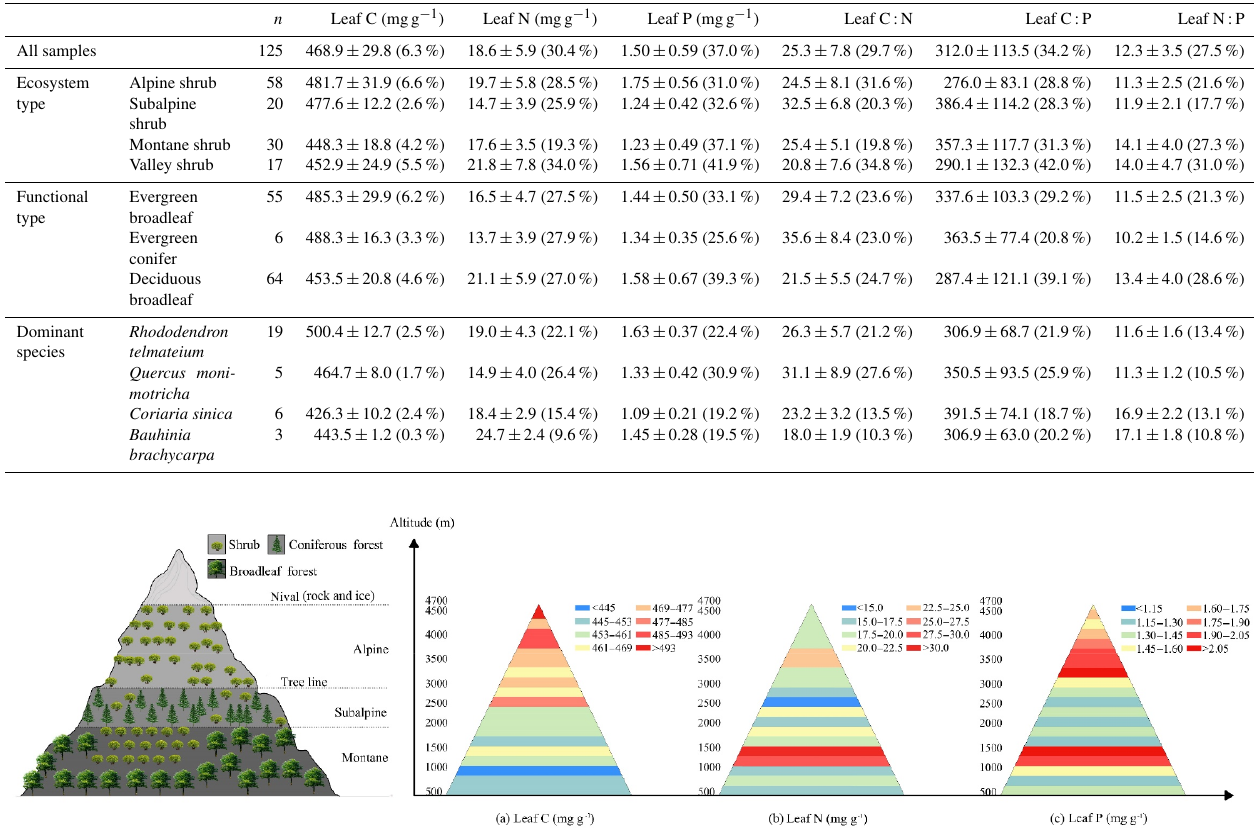
Figure 2. Vertical distribution of leaf C, N and P contents of mountainous shrubs on the Tibetan Plateau. Alpine shrub occurs at relatively high altitudes (3091–4685m, above tree line), followed by subalpine shrub (2000–4078m, coniferous forest zone), montane shrub (523–3342m, broadleaf forest zone) and valley shrub (600–2350m, valley